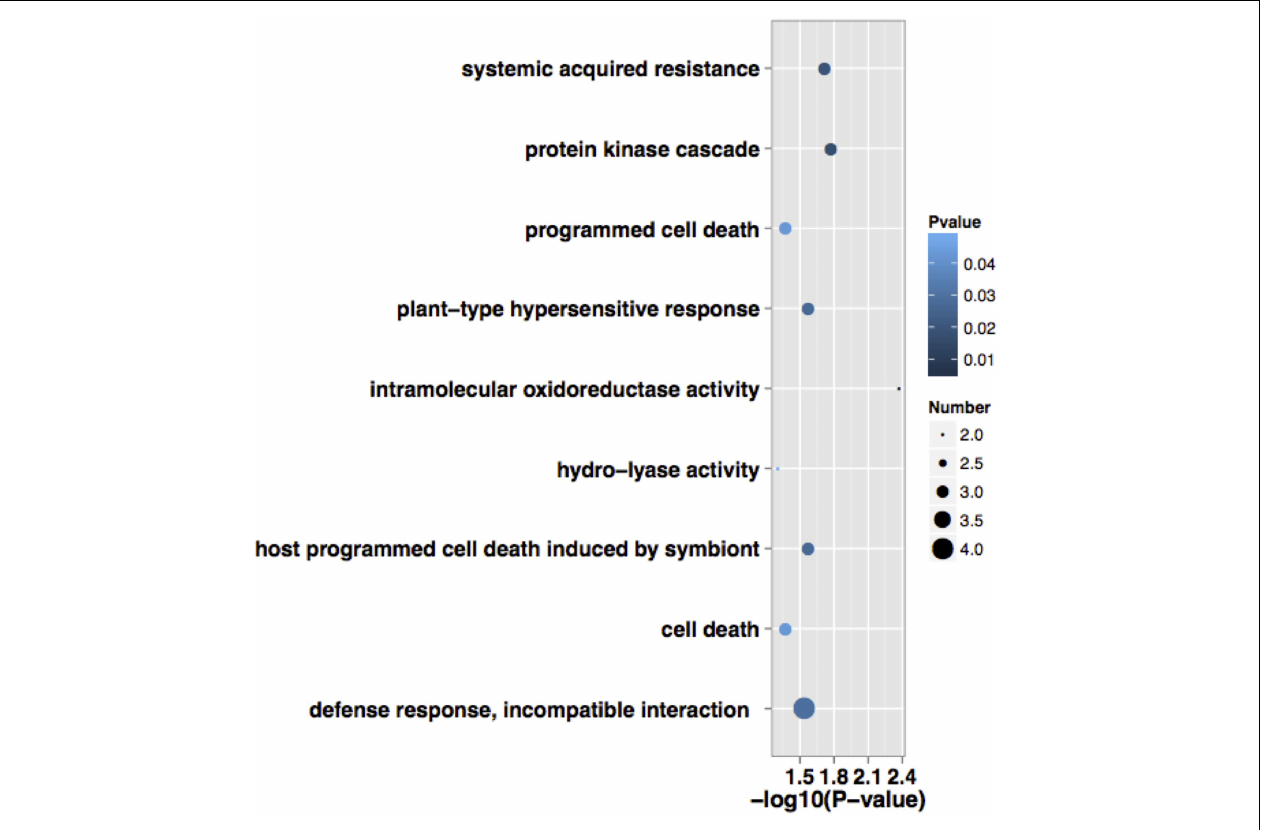
FIGURE 4 | Functional significant enrichment of the identified proteins during alfalfa flower development. Point size indicate the numbers of annotated differential proteins, color depth indicate the P -value of enrichment. The detailed significant enrichment of all identified proteins are shown in Supplementary Table